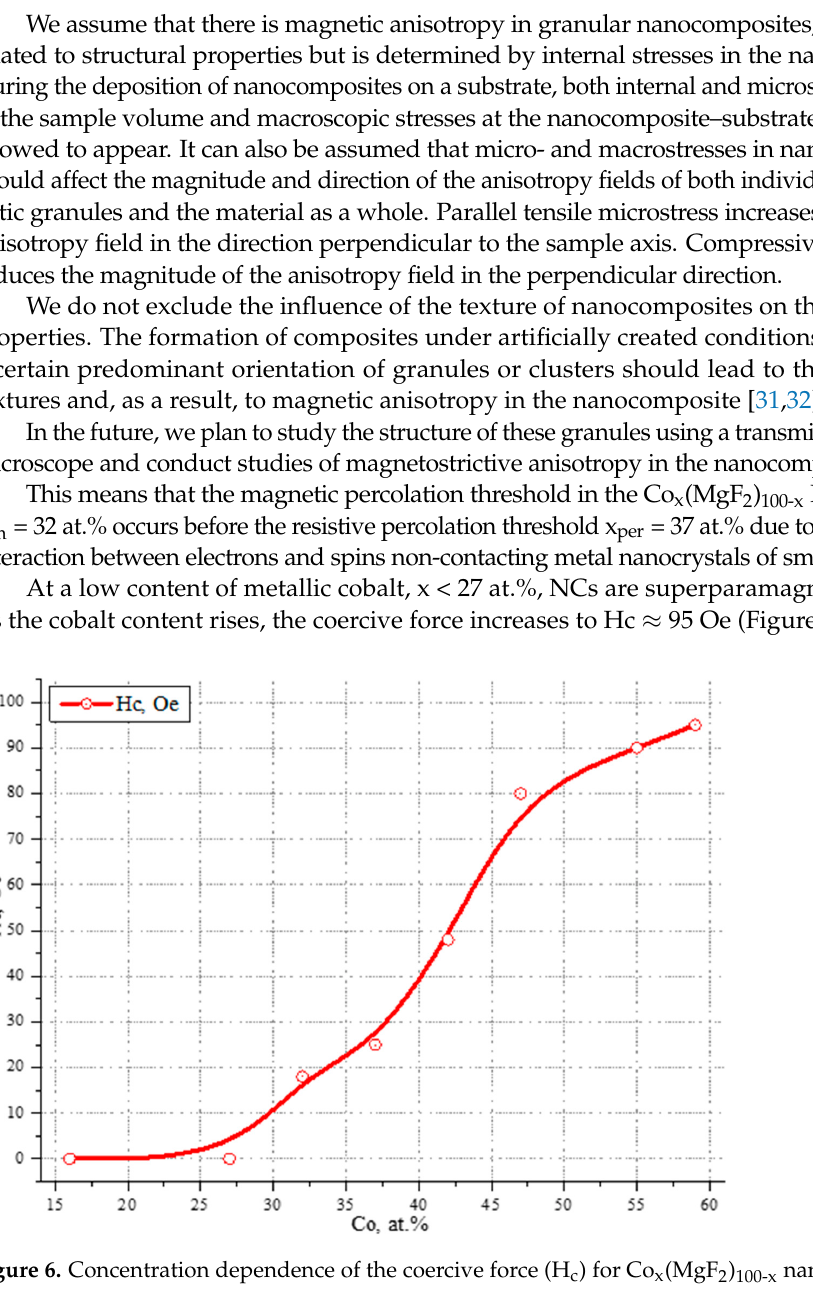
Figure 6. Concentration dependence of the coercive force (H c ) for Co x (MgF 2 ) 100- х